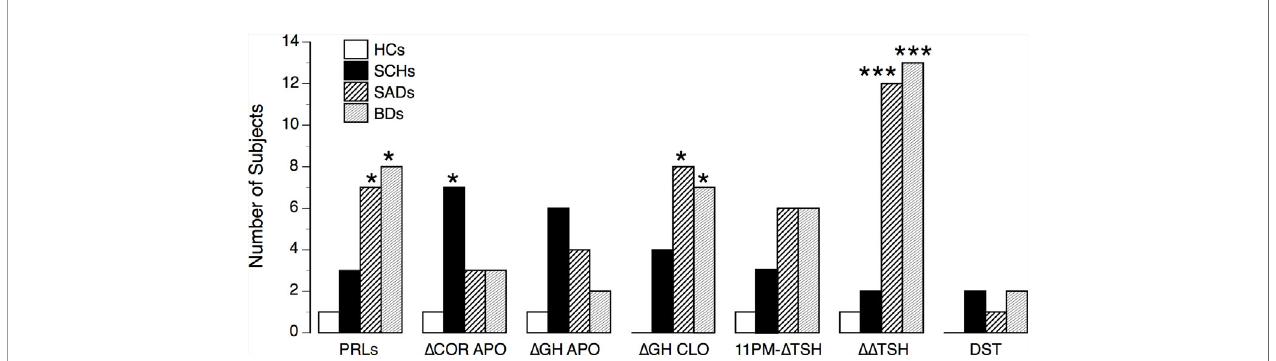
FIGURE 5 | Number of abnormal test responses in controls and patients. HCs, healthy control subjects; SCHs, patients with paranoid schizophrenia; SADs, patients with schizoaffective disorder; BDs, patients with bipolar depression. PRLs, prolactin suppression following apomorphine (APO); D COR APO, maximum increment in serum cortisol level above baseline after APO; D GH APO, maximum increment in serum growth hormone (GH) level above baseline after APO; D GH CLO, maximum increment in serum growth hormone (GH) level above baseline after clonidine (CLO); 11 PM- D TSH, maximum increment in serum thyrotropin level above baseline ( D TSH) after protirelin (TRH); DD TSH, difference between 11 PM- D TSH and 8 A- D TSH values. Comparisons between HCs and patients: *p < 0.05; ***p < 0.001 (by Fisher ’ s exact